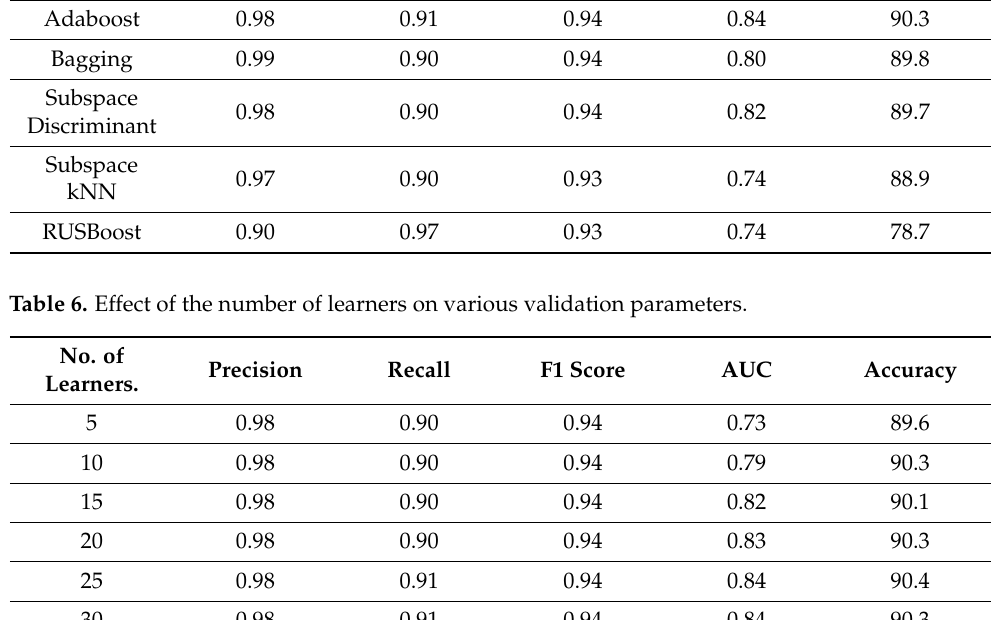
Table 6. Effect of the number of learners on various validation parameters.